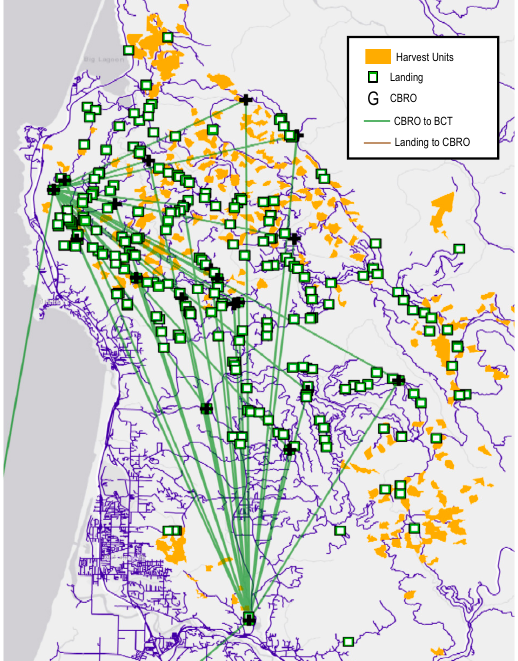
Figure 4. Network analysis results for location-allocation tool for scenario VI. Straight lines are for visualization and haul distances are calculated using road distance. Table 2. The number of centralized biomass recovery operation (CBRO) and biomass conversion technology (BCT) sites for each scenario within logistics models (LM) I and II, respectively .